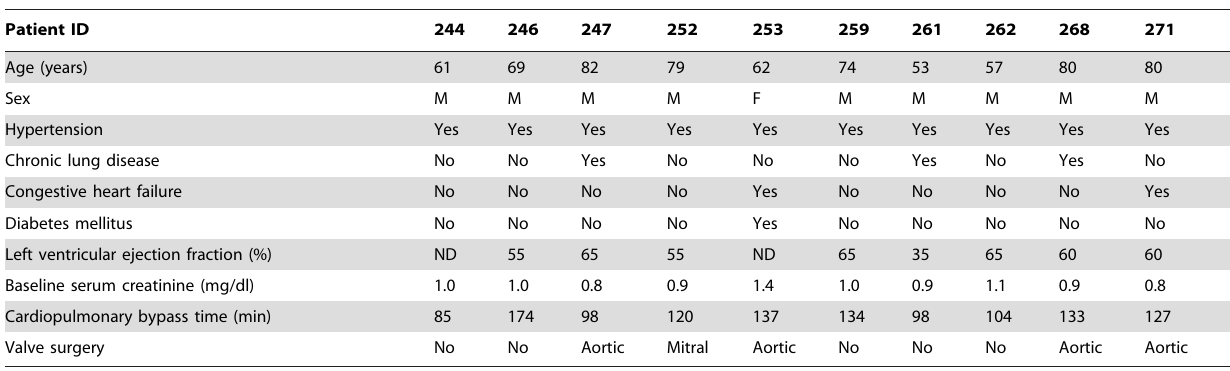
Table 1. Clinical characteristics of the study